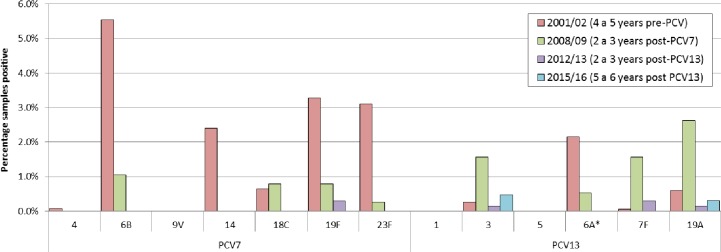
The carriage of PCV13 types in the four consecutive carriage studies performed in the two study sites.The study in 2001/02 was a longitudinal study the three subsequent studies cross-sectional. *The percentage of samples positive for serotype 6A in 2001/02 was post-hoc corrected for 6C (6A is 68% of original) as described in Flasche et al. [7].